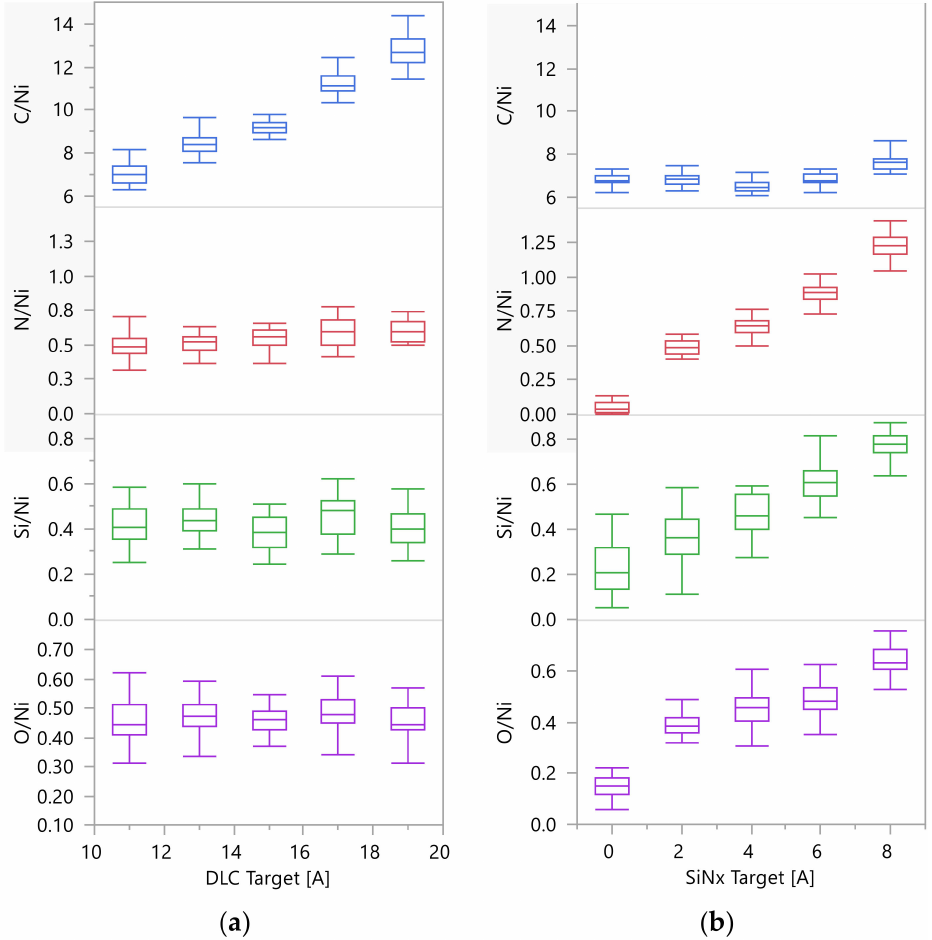
Figure 4. EDX C/Ni, Si/Ni, N/Ni and O/Ni ratios as a function of deposited carbon for the DLC ladder ( a ), and of the deposited SiN x for the seed ladder ( b ), both with 2 Å